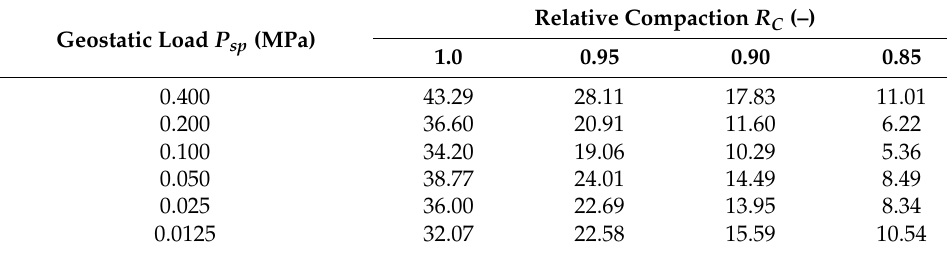
Table A1. Secant Constrained Recycled Concrete Aggregate (RCA) Modulus, E ode .